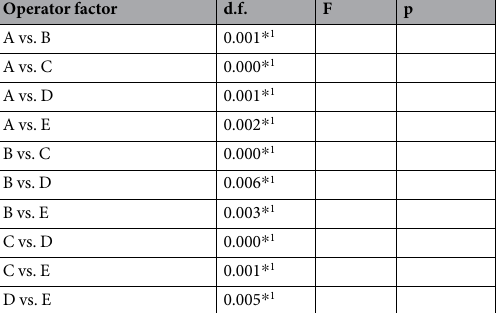
Table 4. Non parametric MANCOVA on precision measurements (tooth movement) performed by different operators, time points, and settings. Three crossed factors and their possible interactions were analyzed in each case having patient as a covariate: superimposition technique (fixed factor; 5 techniques), tooth (random factor; 3 teeth), and operator (fixed factor; 2 operators) or time (fixed factor; 2 time points) or setting (fixed factor; 2 settings). All vectors of positional change of each tooth were considered as dependent variables (6 vectors: x-lateral movement, y-anteroposterior movement, z-vertical movement, x-torque, y-tip, z-rotation). * p < 0.05. 1 Monte Carlo asymptotic p-value. 2 Tests among levels of the factor Superimposition. A, B, C, D, E correspond